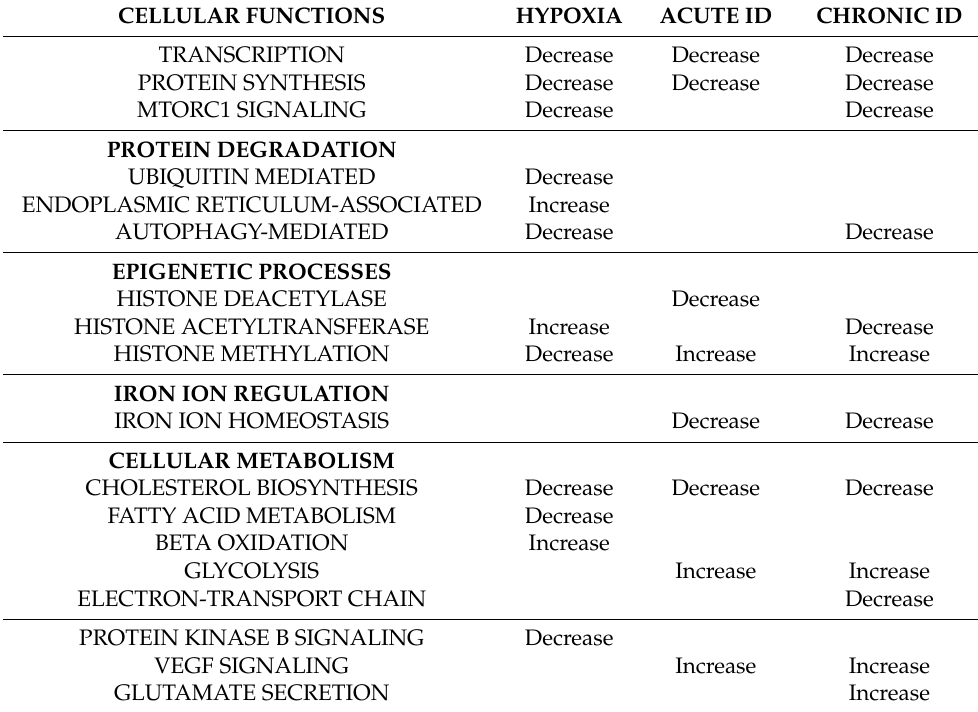
Figure 2. Enrichment and clustering analysis of the oxygen and iron deficiency proteome datasets based on Gene Ontology annotations. Gene Ontology annotation classified genes based on four categories: ( A ) Biological Process, ( B ) KEGG Pathways, ( C ) PFAM analysis, and ( D ) molecular functions. In each category, SILAC quantification ratios of all proteins were divided into four quantiles based on the normalized heavy/light Log2 SILAC ratios (less than − 1, − 1 to 0, 0 to 1, more than 1). An enrichment test was performed using Benjamini–Hochberg adjustment. The P-values were transformed into z-scores before hierarchical clustering analysis. Table 1. Dynamics of protein pathways regulated by hypoxia, acute iron deficiency, and chronic iron deficiency. Functional activity is summarized either as increased, decreased, or unchanged (blank).